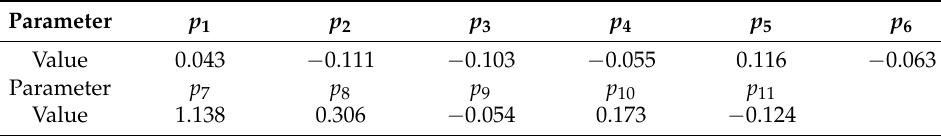
Table 5. Fitting results of the damping coefficient c 1 .